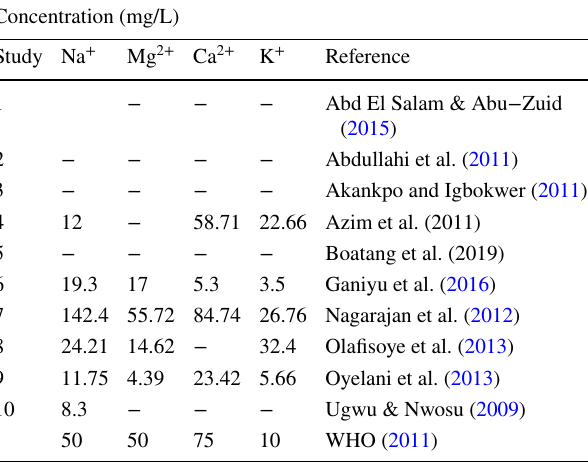
Table 6 Concentration of metals in groundwater at various dumpsites